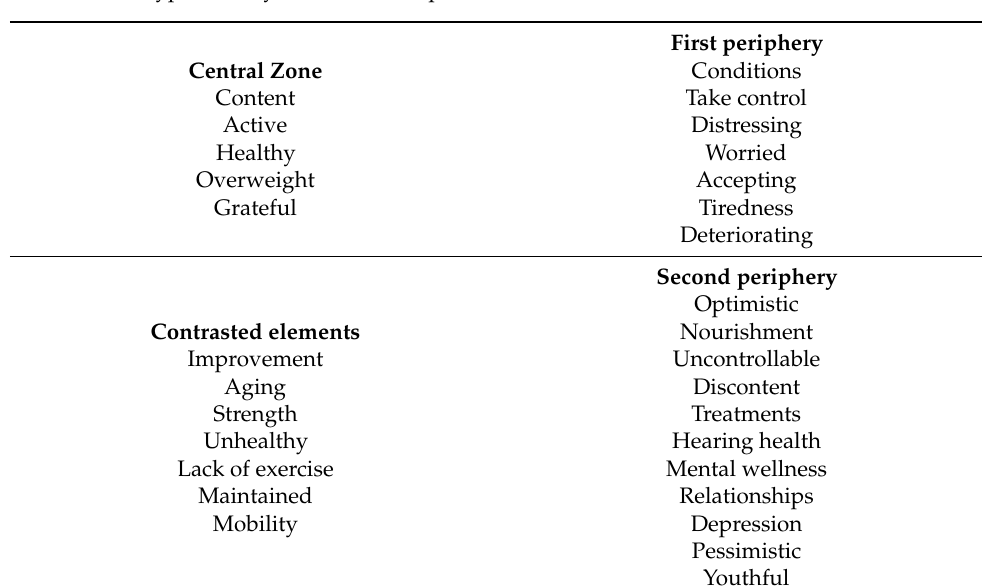
Table 5. Prototypical analysis of health